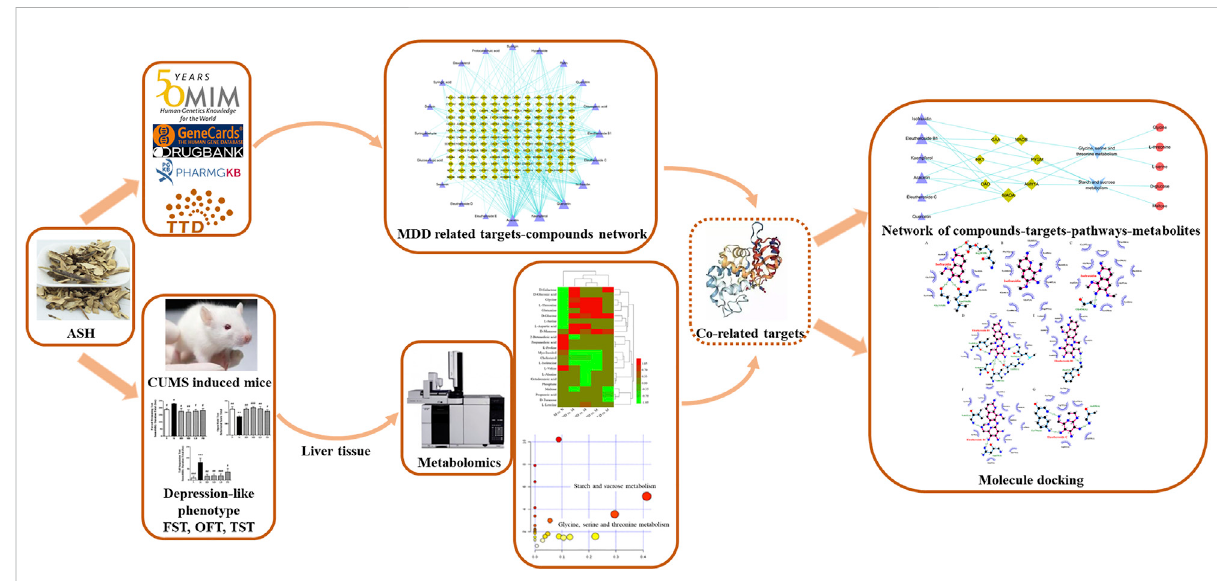
FIGURE 1 Work scheme of this study. ASH: Acanthopanax senticosus (Rupr. et Maxim.) Harms; FST: forced swimming test; MDD, major depressive disorder; OFT, open- fi eld test; TST, tail suspension